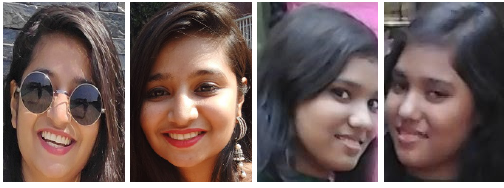
Figure 1. Examples from collected ORL database